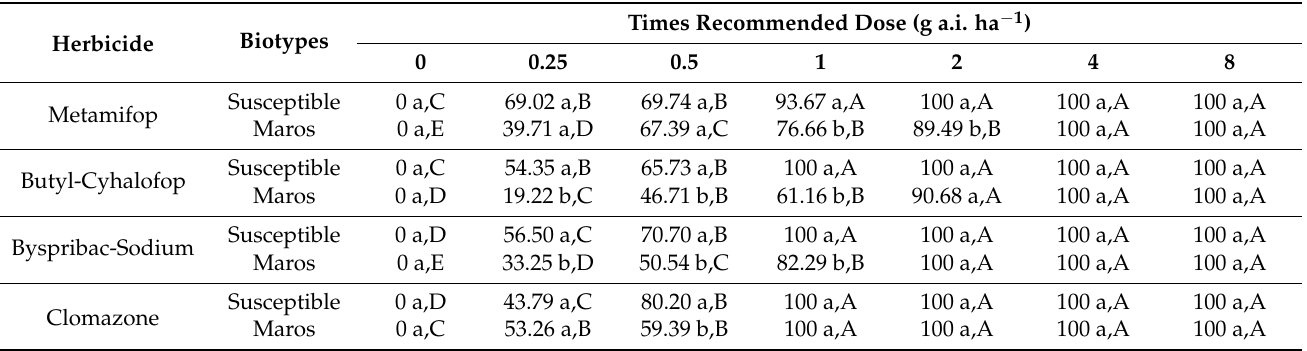
Figure 1. Effects of herbicides on susceptible and Maros biotypes of L. chinensis . Herbicides were applied at seven dosage levels at two weeks after sowing of L. chinensis : metamifop (0, 31.25, 62.5, 125,250, 500, and 1000 g a.i. ha − 1 ), and cyhalofop-butyl (0, 31.25, 62.5, 125, 250, 500, and 48, 96, 192, and 384 g a.i. ha − 1 ). Table 1. Effects of herbicides on the growth reduction (%) of susceptible and resistant L. chinensis